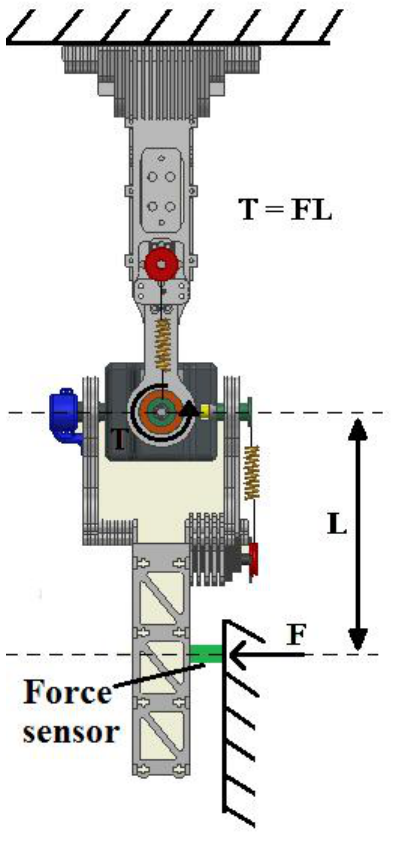
Figure 10. Torques exerted by the MACCEPAs are measured by blocking the output link and using force